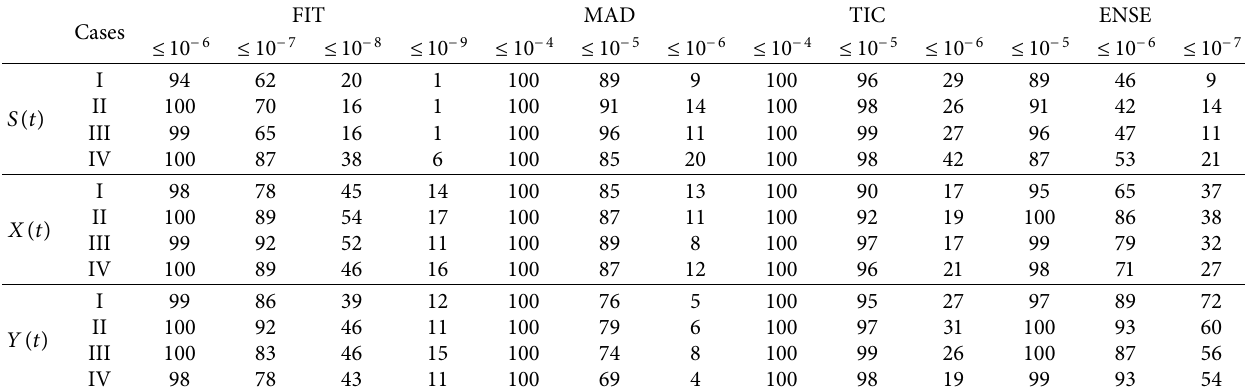
Table 25: Convergence analysis of population density of local prey, immigrant prey, and predator under the influence of variations in the increasing rate of immigrant prey α . 2